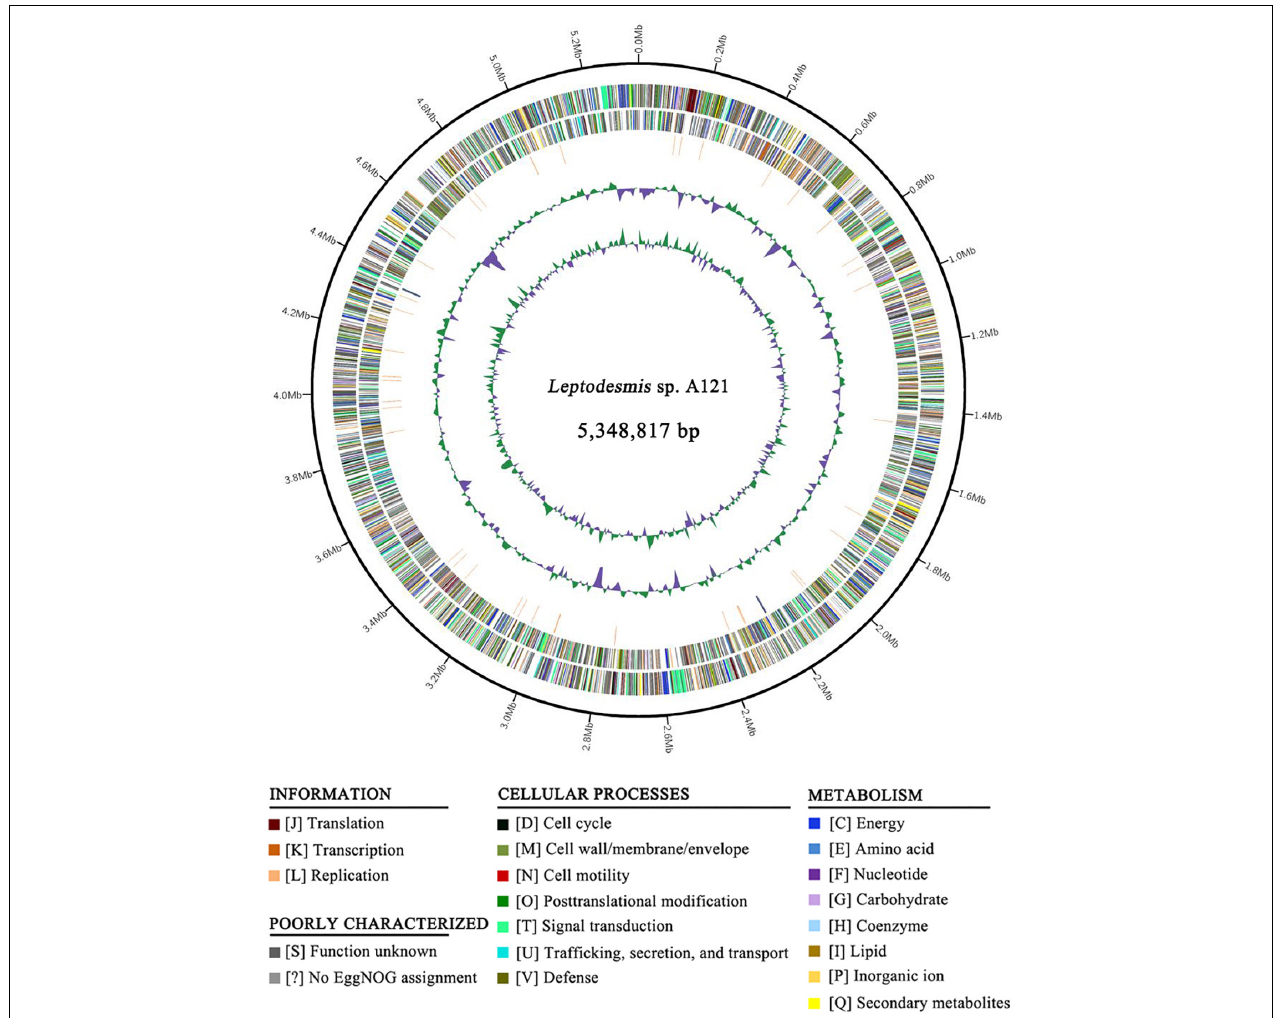
FIGURE 1 | Genome illustration of Leptodesmis sp. A121. Rings are as follows (outer–inner): CDS on plus strand; CDS on minus strand; rRNA (orange) and tRNA (blue); the last two circles represent GC content and GC skew both calculated for a 10 kb window with 1 kb stepping. The CDS are color-coded by functional categories of EggNOG